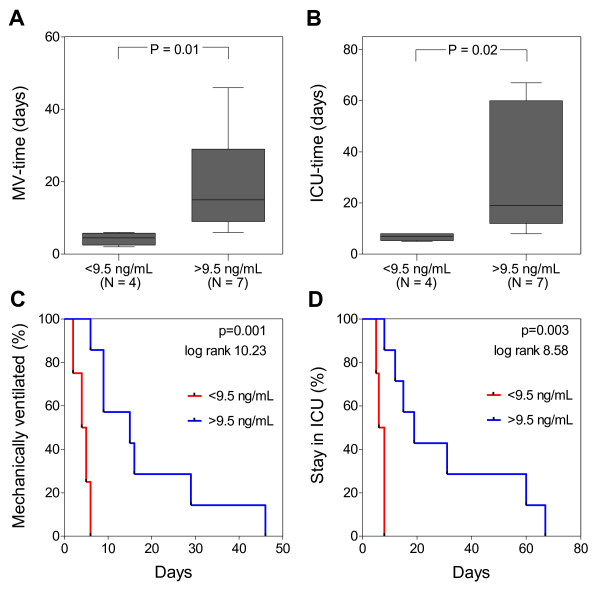
Prognostic value of soluble urokinase-type plasminogen activator receptor (suPAR). Box plot of (a) duration of mechanical ventilation and (b) length of stay in the ICU of burn-injury patients with inhalation trauma. Boxes represent the interquartile ranges. N, number of patients per group. Kaplan-Meier curves showing the rate of freedom from (c) mechanical ventilation and (d) ICU stay in burn-injury patients with systemic suPAR < 9.5 ng/ml and > 9.5 ng/ml. P values are given in each panel.